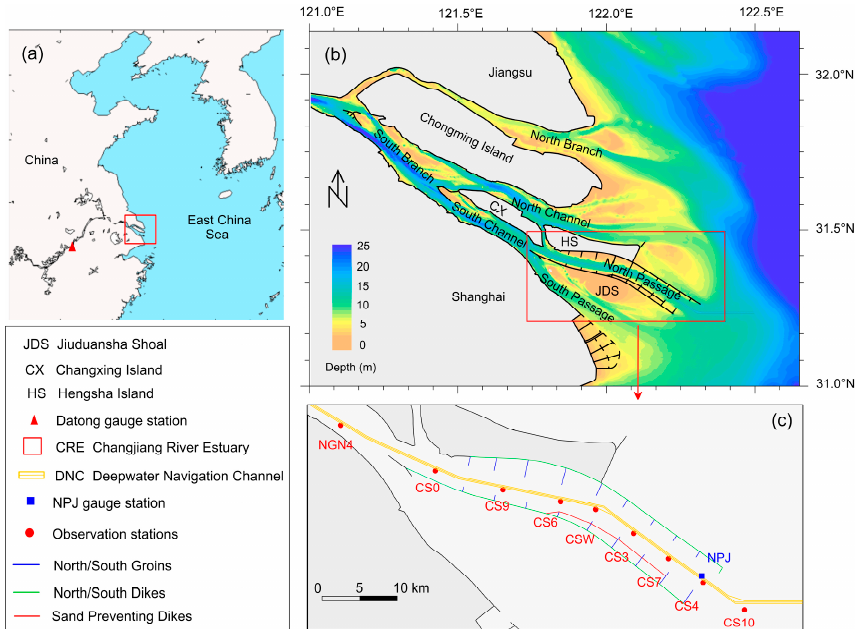
Figure 1. ( a ) Location of the Changjiang River Estuary and Datong gauge station, ( b ) topography of the Changjiang River Estuary (refer to the 85 National Vertical Datum of China), and ( c ) the location of observation stations and the Deepwater Navigation Channel (DNC) project (upper reach: NGN4–CS9, middle reach: CS6–CS3, and lower reach: CS7–CS10).